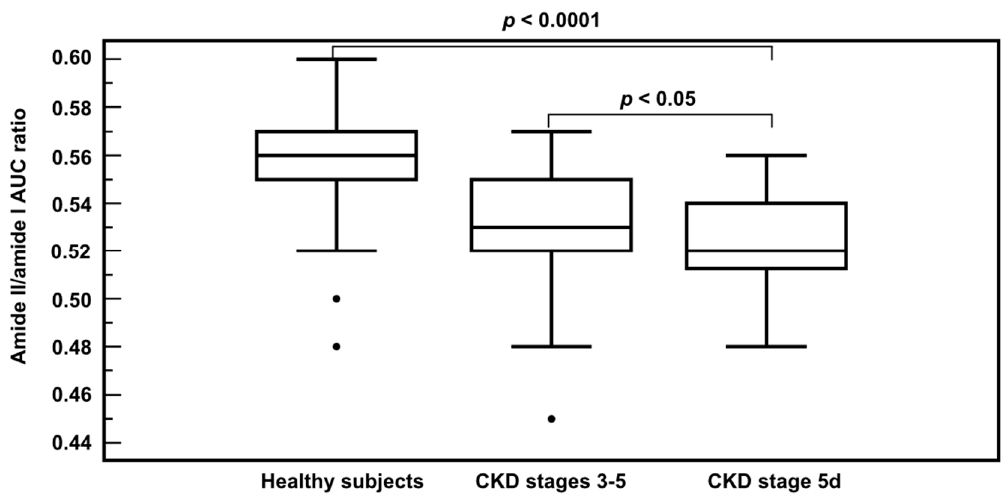
Figure 3. Amide II/amide I AUC ratio among the different study groups. Figure 3. Amide II / amide I AUC ratio among the di ff erent study groups.